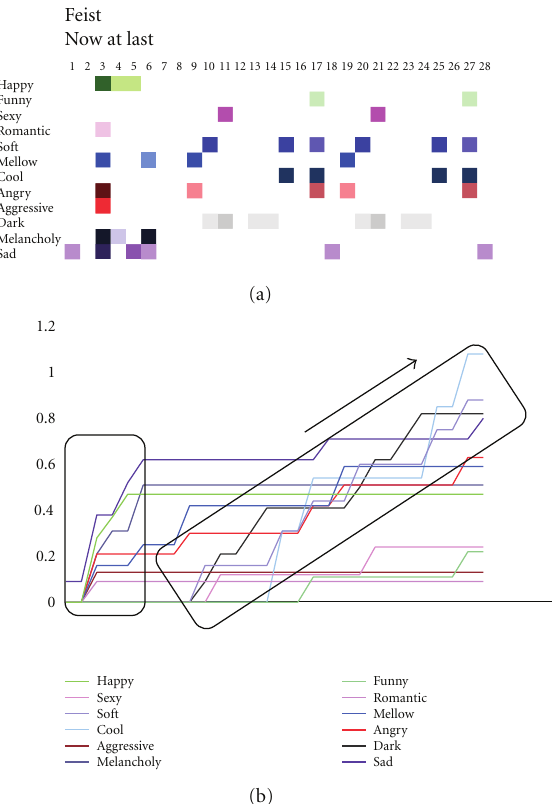
Figure 5: Summed up values of LSA correlation between (a) the lyrics of the song “Now at last” and 12 a ff ective terms, with (b) accumulated values plotted over the entire length of the